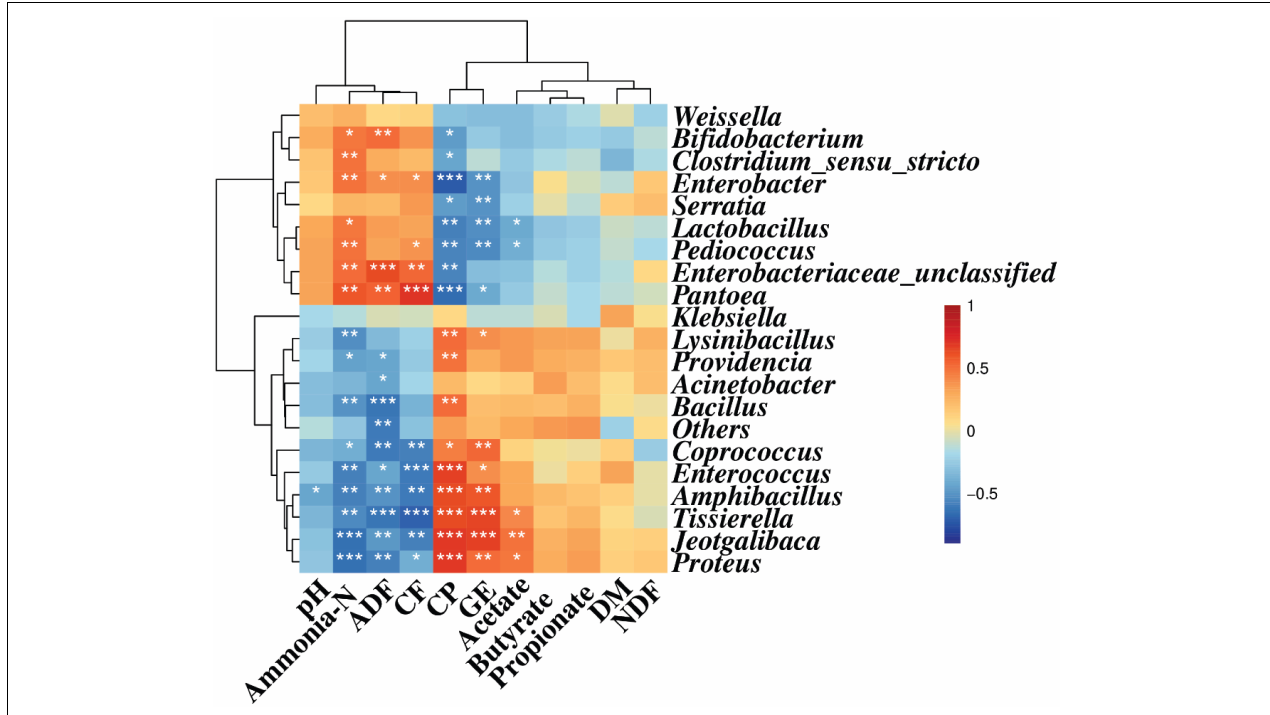
FIGURE 2 | Spearman correlation heatmap between the main genera and silage quality. R was presented in different colors; the right side of the legend is the color range of different R values. AL, control; AS1, 0.5% sucrose; AS2, 1.0% sucrose. The value of p ≤ 0.05 is marked with “*”, p ≤ 0.01 is marked with “**”, and p ≤ 0.001 is marked with